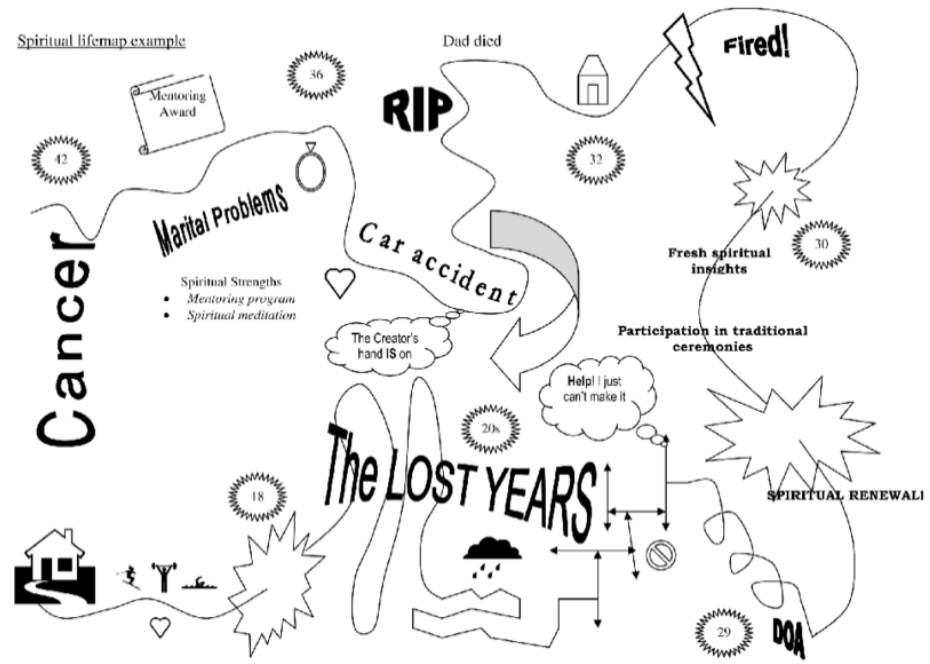
Figure A1. The spiritual life map. Reprinted with permission from Hodge (2005). Copyright 2005 Oxford University Press.